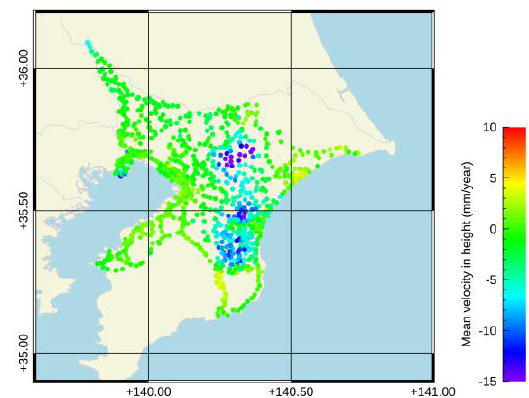
Figure 1. Location of the study area. The red stars indicate GeoNET stations.